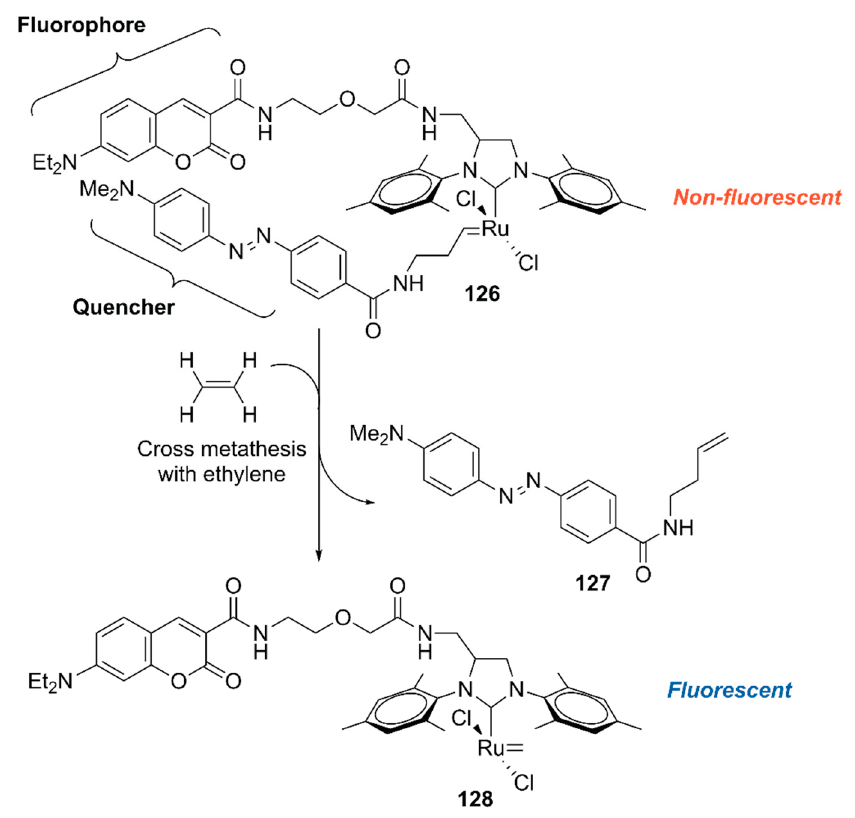
Figure 26. Ethylene-dependent fluorescence switching by a ruthenium complex [140].